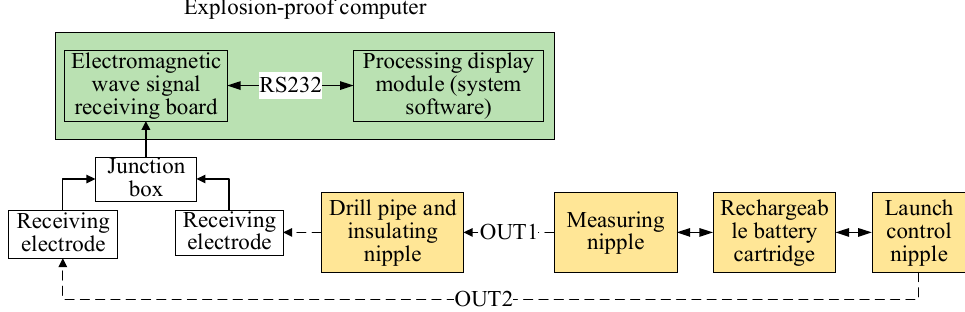
Figure 7. Working principle of mine mud pulse wireless MWD system.